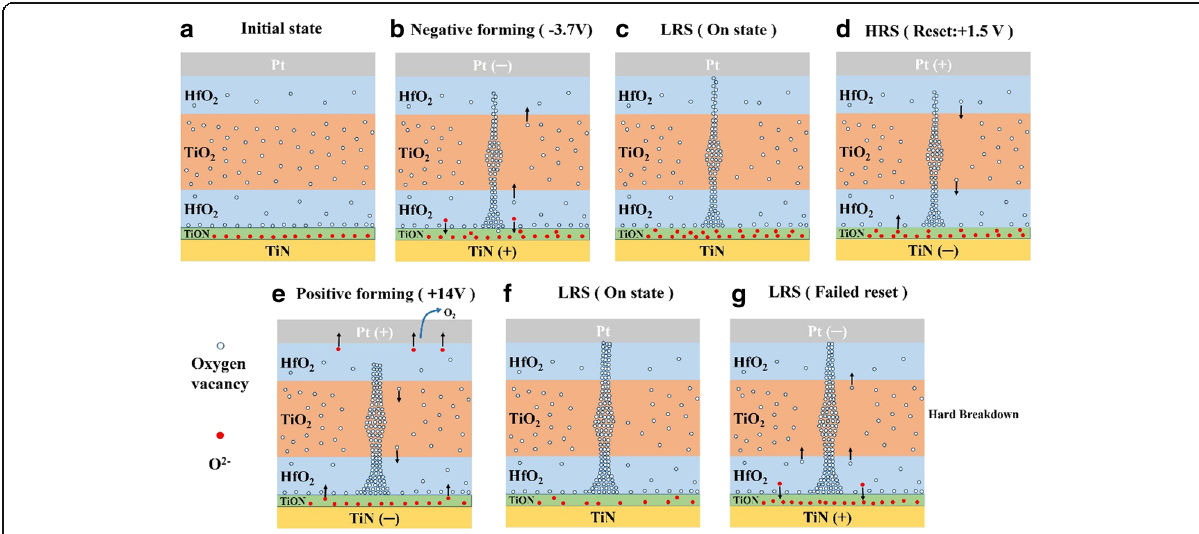
Fig. 9 Schematic diagrams of electroforming and reset of trilayer-structure of HfO 2 /TiO 2 /HfO 2 with asymmetric Pt top electrode and TiN bottom electrode. a – d Electroforming at negative voltage and reset at positive voltage. e – g Electroforming at positive voltage and reset at negative